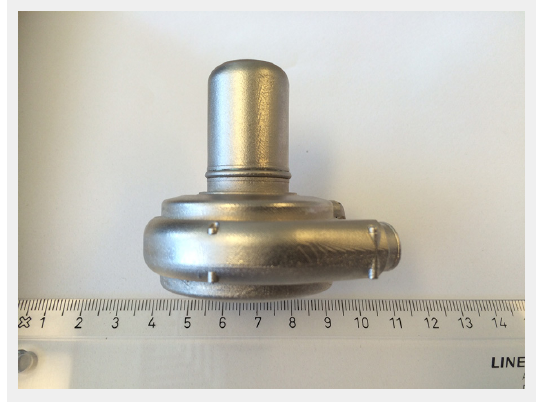
The HeartWare (HeartWare Corporation, Framingham, Massachussetts, USA) device (HVAD) is a centrifugal, continuous flow pump with a wide-blade impeller that is magnetically and hydrodynamically suspended. HVAD pump flow is preload dependent and afterload sensitive with a speed range of 1800–4000 RPM and a maximum outflow of 10 l/min. HVAD weight is 160 g and it fits in a hand.